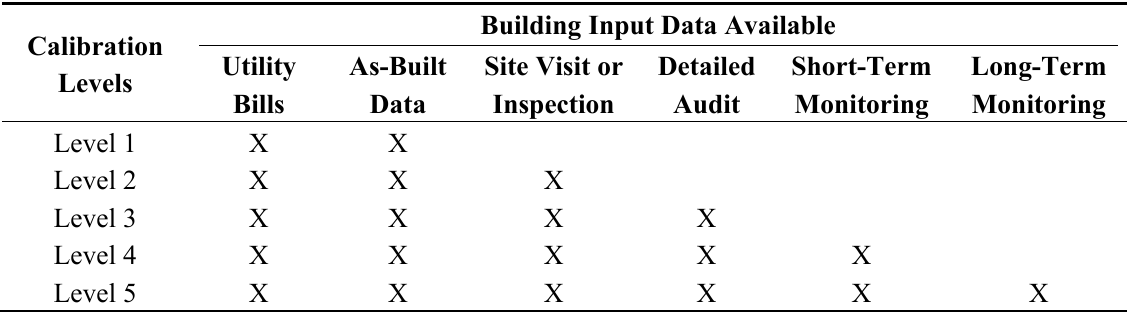
Table 1. Calibration levels based on the building information available